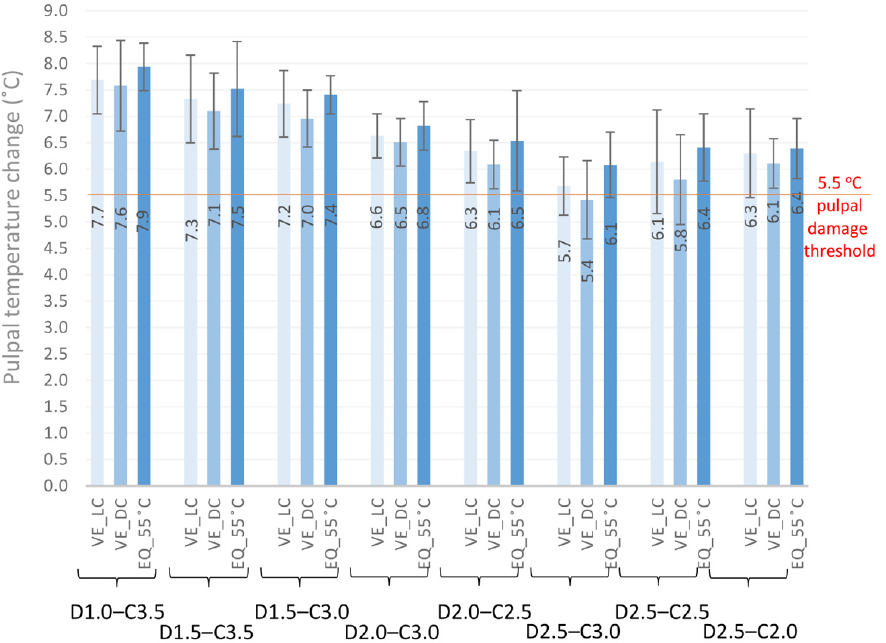
Figure 4. Comparisons of the pulpal temperature changes caused by the polymerization of light-cured and dual-cured adhesive cements and by the preheated restorative resin composite through eight different combinations of dentin and ceramic thicknesses (one-way ANOVA and Tukey’s post-hoc test did not result in statistically significant differences between the tested groups). The mesh figure shows that the dentin thickness below 1.5 mm is the most critical for the heat insulating effect (Figure 5).